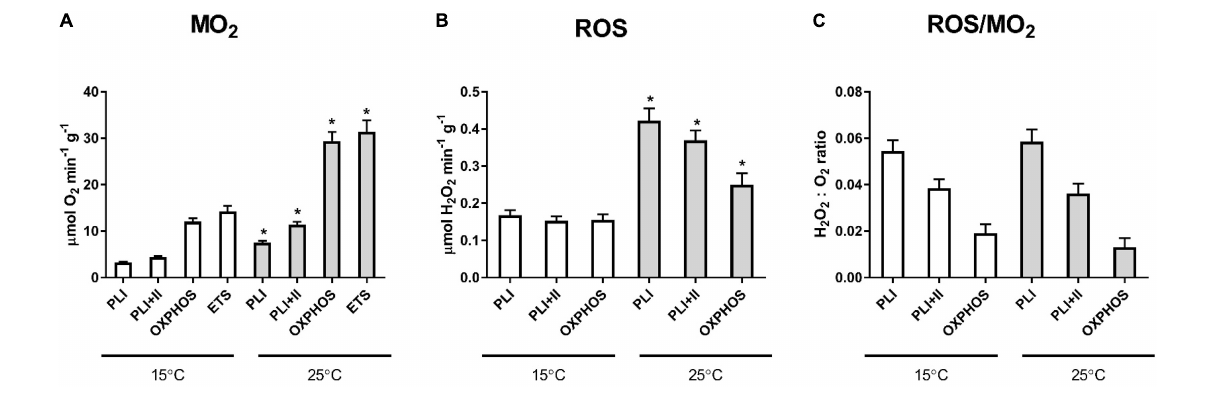
FIGURE 1 | Oxygen consumption rates ( ˙MO 2 ) and ROS efflux of isolated mitochondria respiring at low (15 ◦ C) and high temperatures (25 ◦ C) under control conditions. Significant differences between mitochondrial traits measured at different temperatures are denoted by asterisks (* P < 0.05). PL I indicates proton LEAK